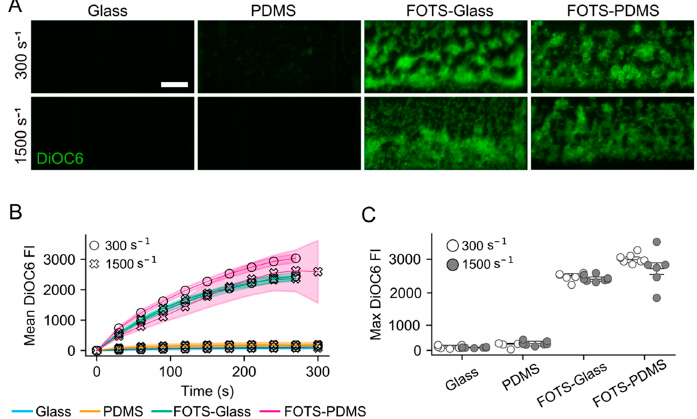
Figure 1. Microfluidic flow assays with polydimethylsiloxane (PDMS) microfluidic patterning. ( A ) Representative images of platelet accumulation on collagen peptides patterned on glass, PDMS, glass functionalized with tridecafluoro-1,1,2,2-tetrahydrooctyltrichlorosilane-glass (FOTS-glass), and PDMS functionalized with FOTS (FOTS-PDMS) after a 5 min perfusion at wall shear rates of 300 s − 1 and 1500 s − 1 . Scale bar = 50 µm; ( B ) Mean Fluorescence Intensity (MFI) of platelet accumulation over time on the four surfaces. Data points are the average of n = 6, and shaded regions are the standard deviation; ( C ) Maximum mean fluorecence intensity of platelet accumulation over 5 min for the four surfaces.